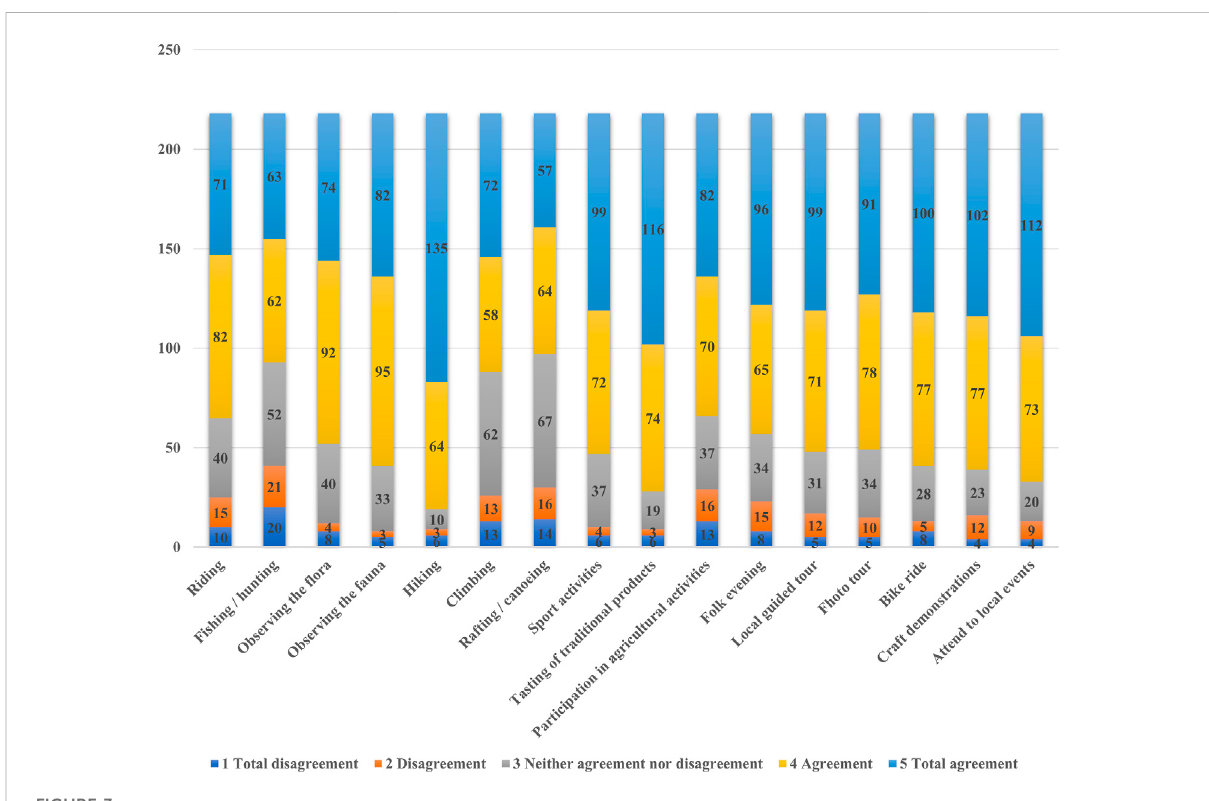
FIGURE 3 Main activities that young people want to carry out in ecotourism